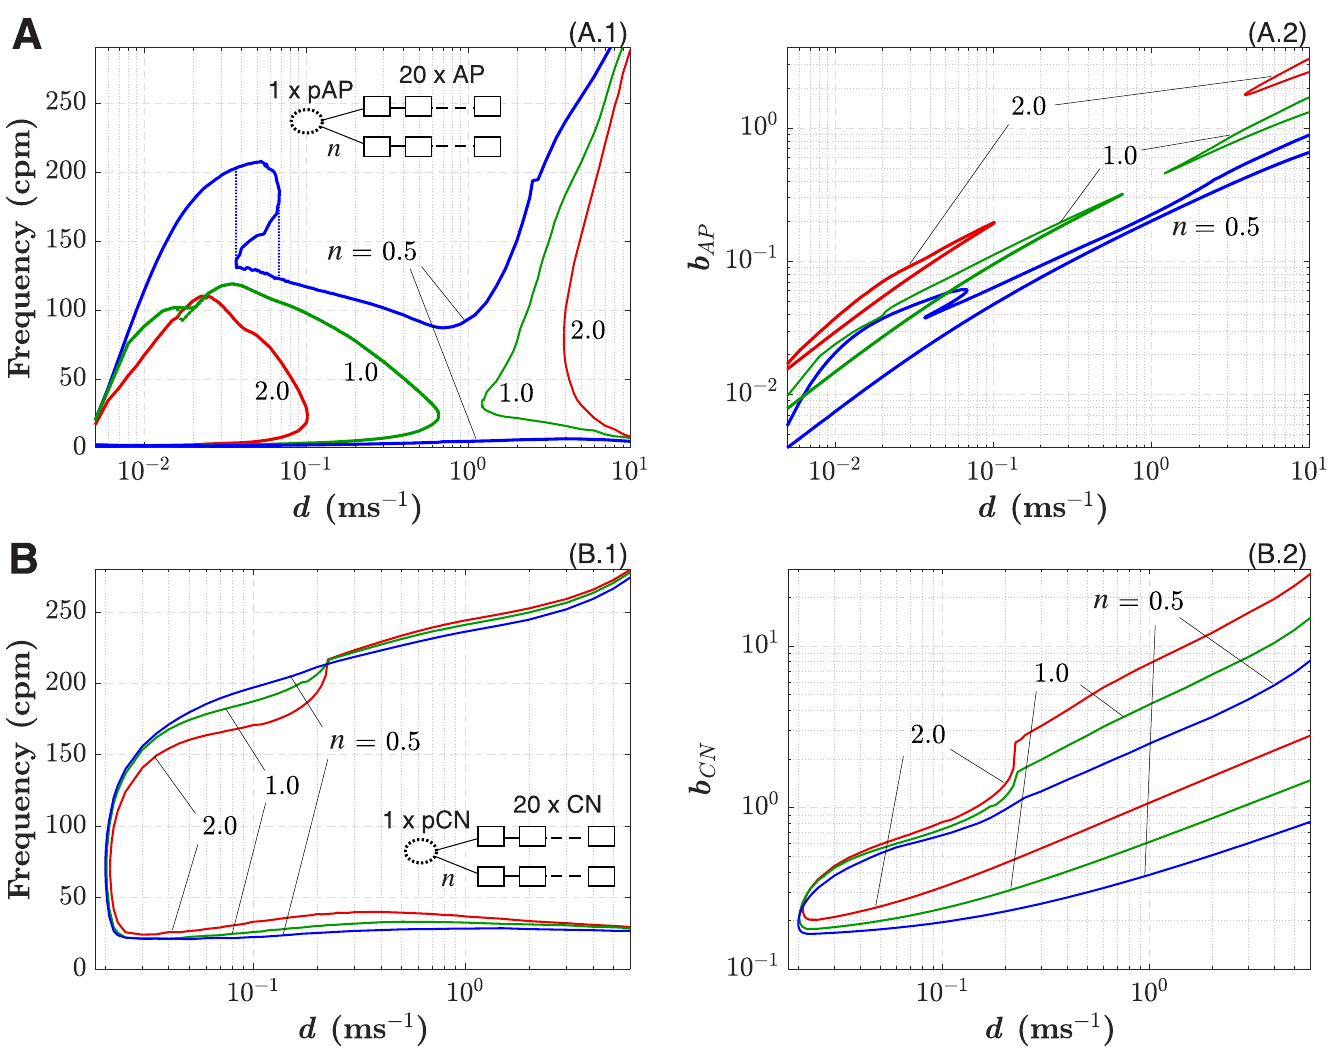
Fig 6. A. 1D pAP-AP coupled system. A.1. Minimal and maximal 1:1 synchronized frequency dependence on the coupling coefficient d for the pAP cell coupled with n = 2 (red), 1 (green), and 0.5 (blues) strands of 20 AP cells. Inset illustrates a schematic representation of the 1D pAP-AP coupled system. Ellipse symbolizes pacemaker cell and rectangles—excitable cells. A.2. Minimal and maximal values of the parameter b system . B.1. Minimal and maximal 1:1 synchronized frequency dependence on the coupling coefficient d for the pCN cell coupled with n = 2 (red), 1 (green), and 0.5 (blue) strands of 20 CN cells. Inset illustrates a schematic representation of the 1D pCN-CN coupled system. B.2. Minimal and maximal values of the parameter b d corresponding to panel